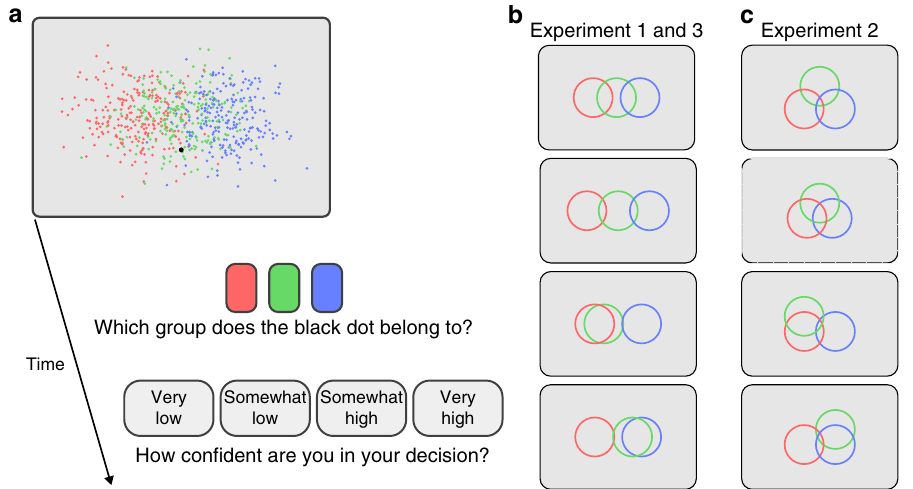
Fig. 1 Experimental procedure and stimuli. a Each trial started with the presentation of the stimulus including exemplar dots in three different colors representing the distribution of each of the three categories and one target dot, the black dot. Observers fi rst reported their decisions in the categorization task and then reported their con fi dence by using the rectangular buttons presented at the bottom of the screen. b , c Schematic representation of the distribution of the categories. The circles are centered at the mean location of each category. The width of the circles corresponds to 2.5 times the standard deviation of the category distribution. ( b ) The four conditions tested in Experiment 1 and 3. c The four conditions tested in Experiment 2. The exemplar dots in ( a ) are based on the distribution depicted in the top panel in ( b